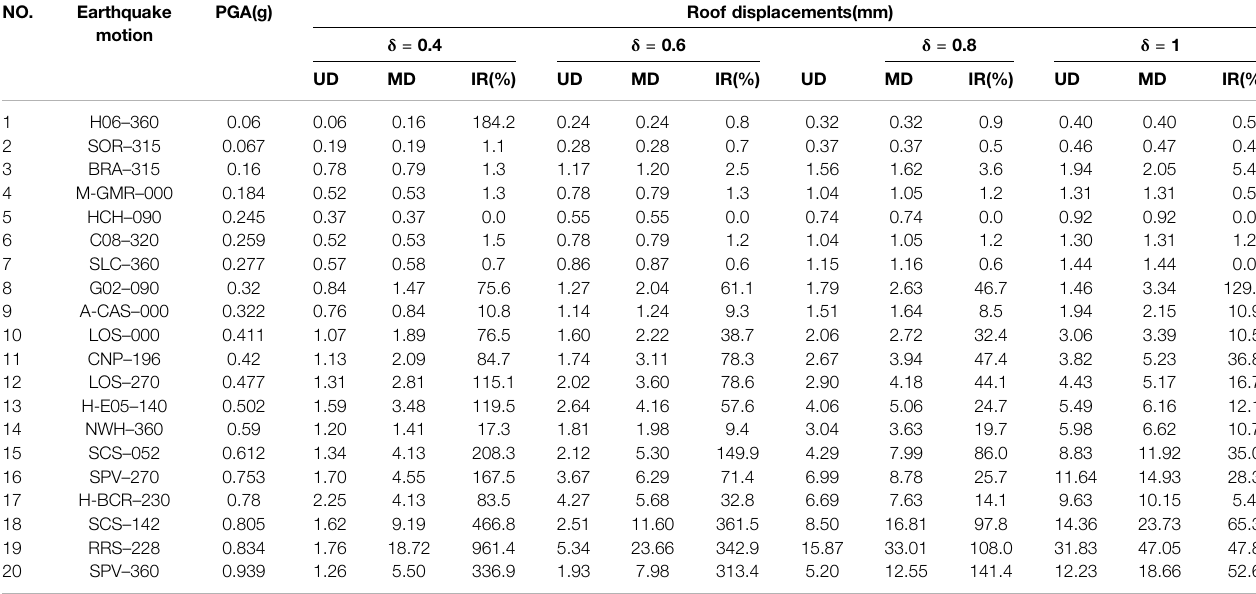
TABLE 3 | Comparison of maximum roof displacements of the undamaged and mainshock-damaged CM models under aftershock. NO. Earthquake motion